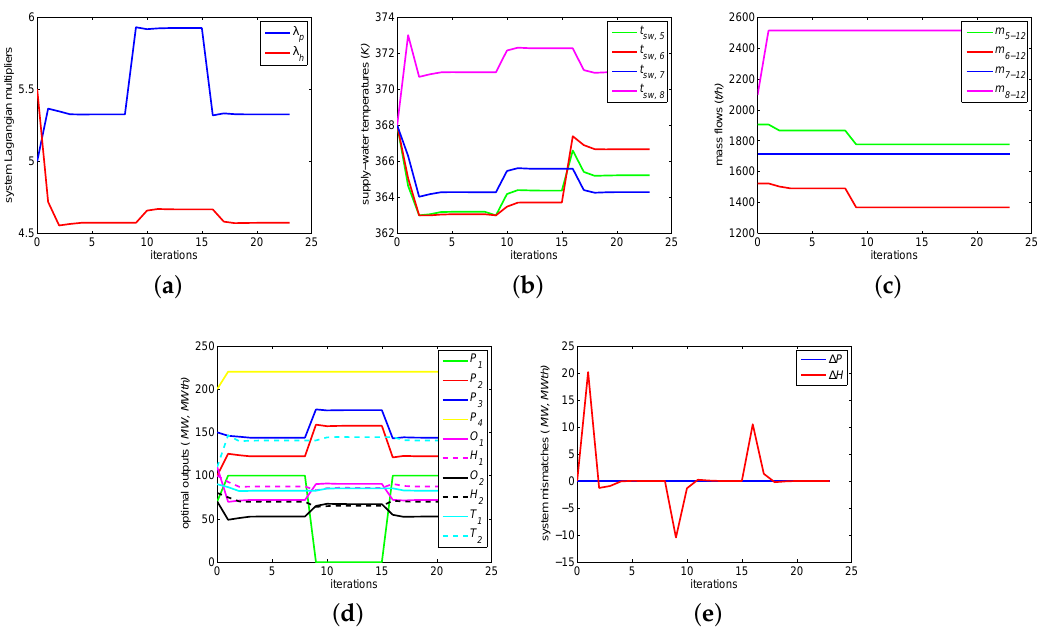
Figure 8. Case study 5: With unit commitment capability. ( a ) system Lagrangian multipliers; ( b ) supply-water temperatures; ( c ) mass flows; ( d ) optimal outputs; ( e ) system